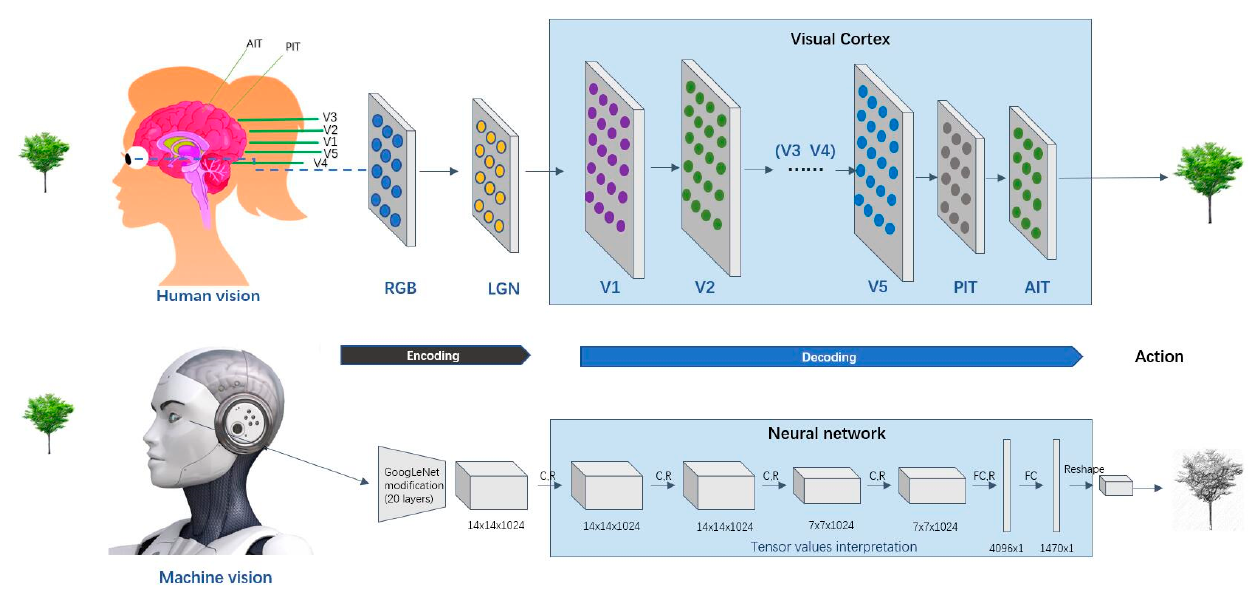
Figure 4. Human vision processing and Representative machine vision processing processes.